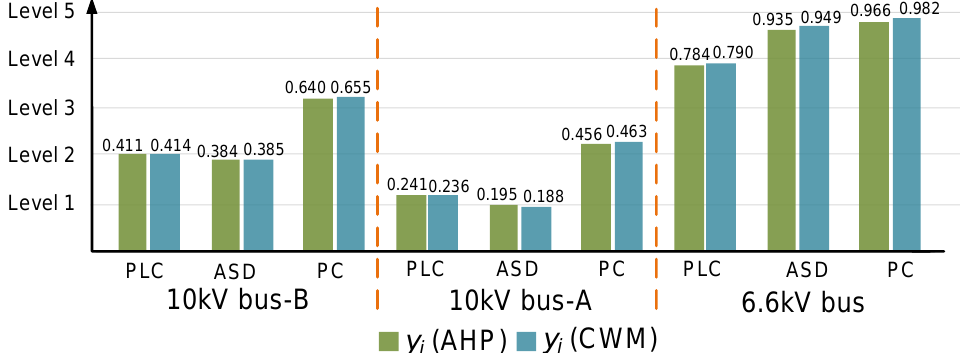
Figure 6. Voltage sag severity level of SPSF.